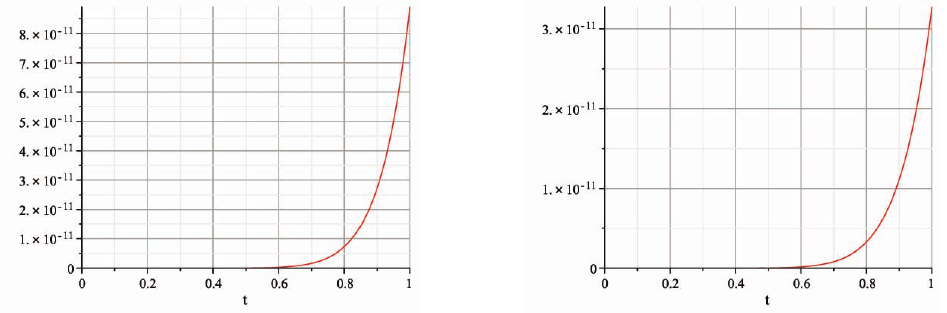
Figure 2: Plot of the | y ( t ) − y